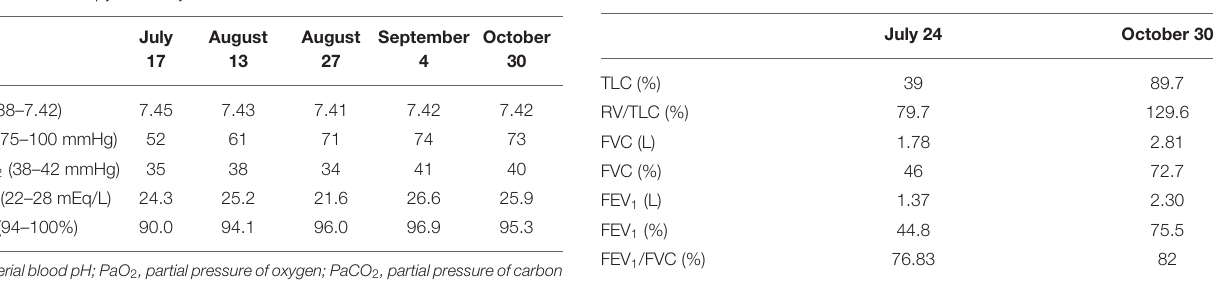
FIGURE 2 | Follow-up chest CT scan of post-COVID-19 pneumonia (second chest CT scan). The chest CT scan performed 4 weeks after the management of severe COVID-19 pneumonia reveals the appearance of bronchiectasis ( A–C ; green arrow), subpleural reticulations ( F ; blue arrow), lobular distortions ( F ; violet arrow), fissure deformity ( C ; orange arrow), paracicatricial emphysema ( D,E ; red arrow), and cavitation in the right middle lobe ( D ; black arrow). TABLE 2 | The normalization of respiratory function after 3 months of treatment TABLE 1 | Gradual and consistent improvement in gasometry under with oral corticosteroids. corticosteroid therapy from July to October 2020.